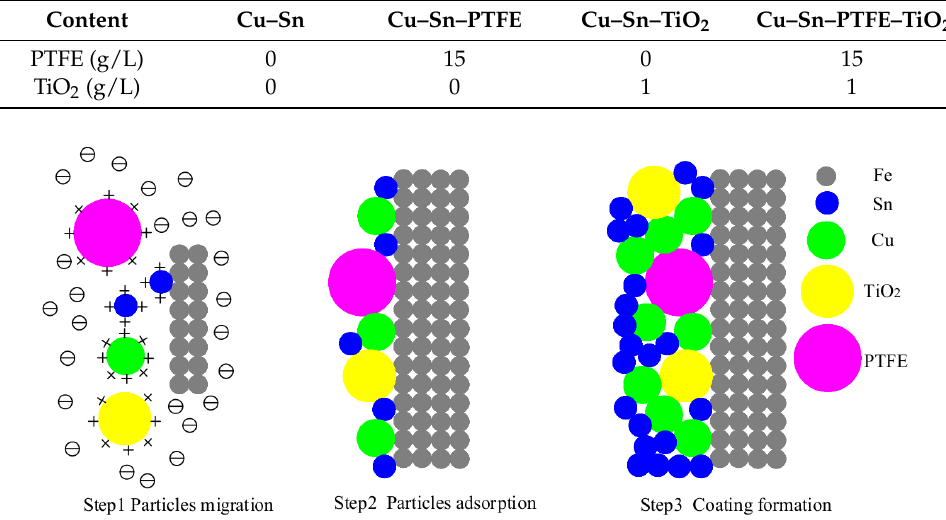
Figure 1. The schematic diagram of the Cu–Sn–PTFE–TiO 2 coating formation process (note that the relative sizes of ions/atoms/particles are not to